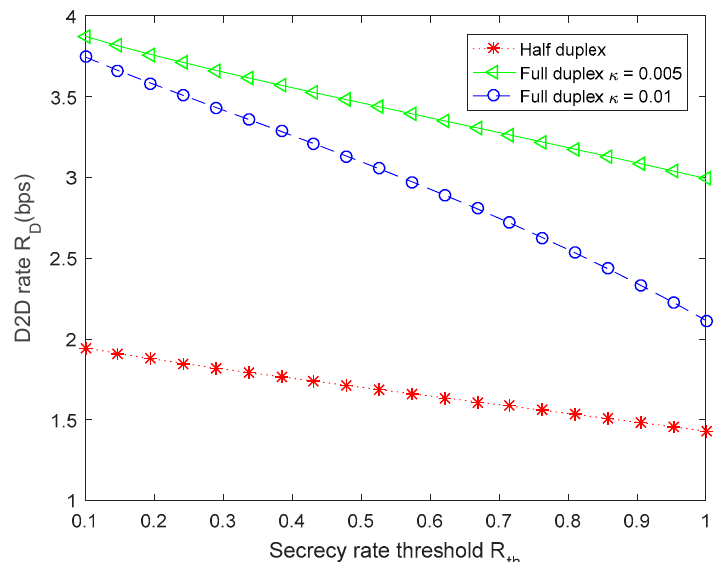
Figure 4. The D2D link rates of FD and half duplex (HD) modes.